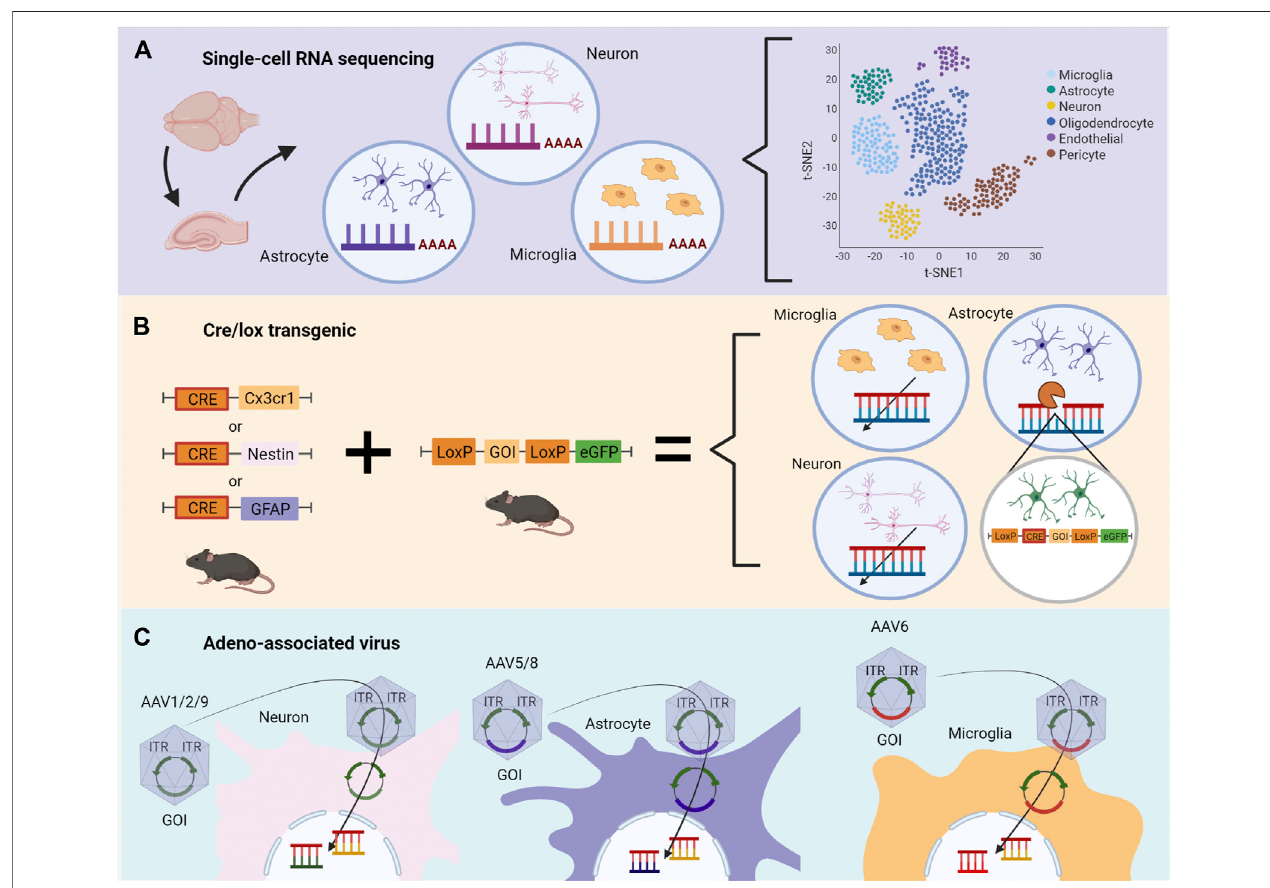
FIGURE2| Methodologicalstrategiestoassessspeci fi crolesofgenesduringepileptogenesisdependingonthecelltype. (A) Single-cellRNAsequencing(scRNA- seq) of the temporal lobe or hippocampus permits the evaluation of changes in transcriptomics triggered by epileptogenesis. Distinct cell types are separately analyzed, and a complete RNA pro fi le is obtained. Changes in transcriptomics are described according to correlation, heatmaps, and quantitative analysis. (B) Cre/lox transgenic technologies can be used to evaluate the role of genes in cell-type-speci fi c during epileptogenesis in vivo . In the fi rst generation, two distinct animals are bred, one containing the Cre enzyme, the other containing two LoxP sequences between the gene of interest (GOI) and a gene reporter, as eGFP. Littermates receive genetic material necessary for the Cre/ fl ox system to modify, delete or change the GOI. (C) Adeno-associated virus (AAV) contains the GOI with inverted terminal repeats (ITR) and viral capsid necessary for cell-speci fi c targeting. The genetic modi fi cation occurs by the transported plasmid carrying the GOI. The illustrations were obtained using BioRender software.